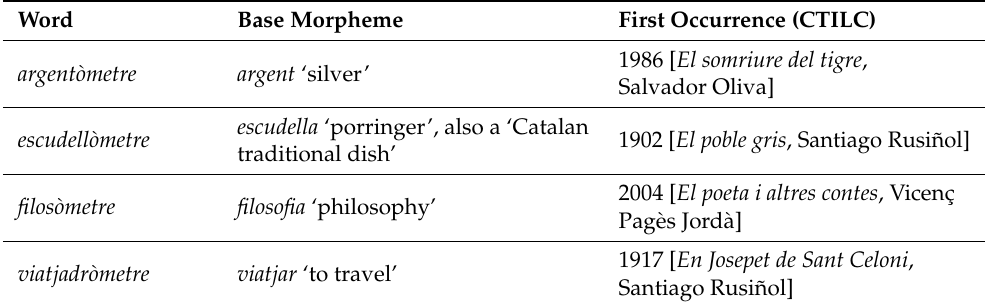
Table 2. Lexical innovations with the combination form - metre ‘-meter’ registered in the